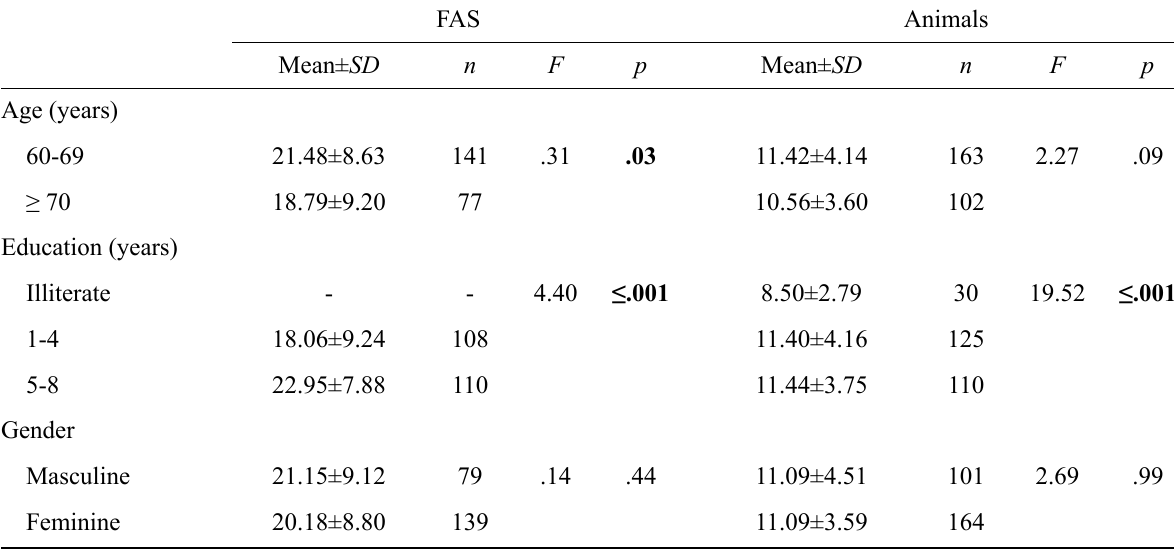
Comparison of Performance on Verbal Fluency Tasks according to Age, Education and Gender Groups FAS